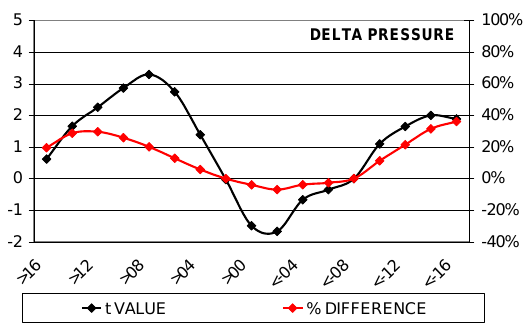
Figure 6. t-test statistics (black line and left-y-axis) for the change of number of hours per decade as function of the MSLP difference between the northern part and the southern boundary of the Adriatic Sea. The red line shows difference (%, right y-axis) in the number of hours. Positive values indicate situations in which MSLP is higher at the southern boundary of the Adriatic Sea then in the north.